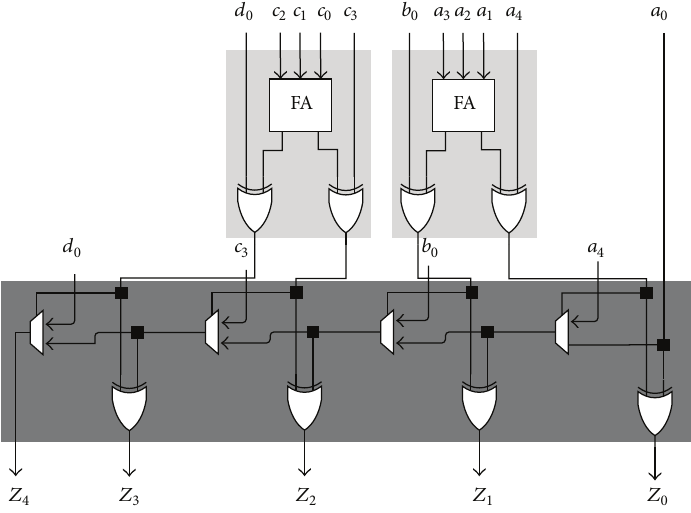
Figure 9: Area optimal mapping for (1, 4, 1, 5; 5)